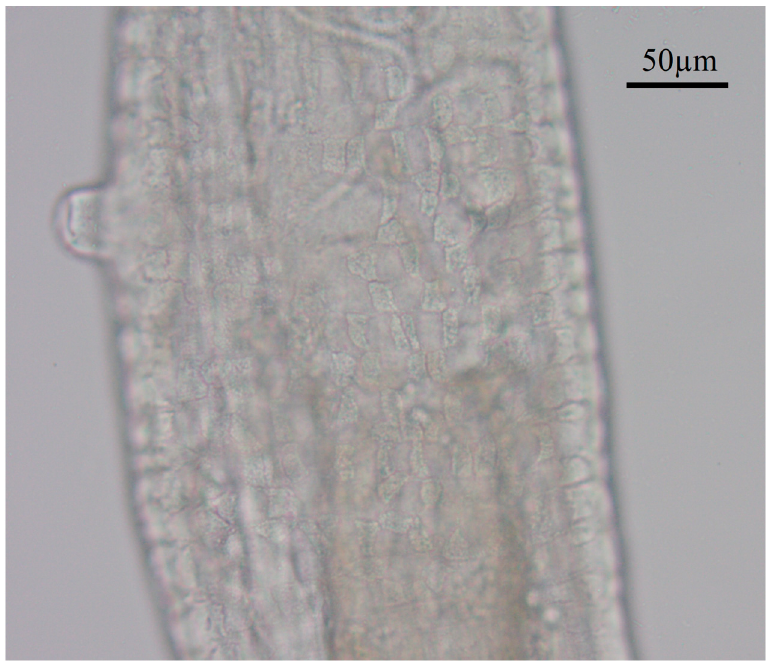
Figure 3. Clitellum of the holotype Fridericia gongalskyi sp. nov., lateral view.